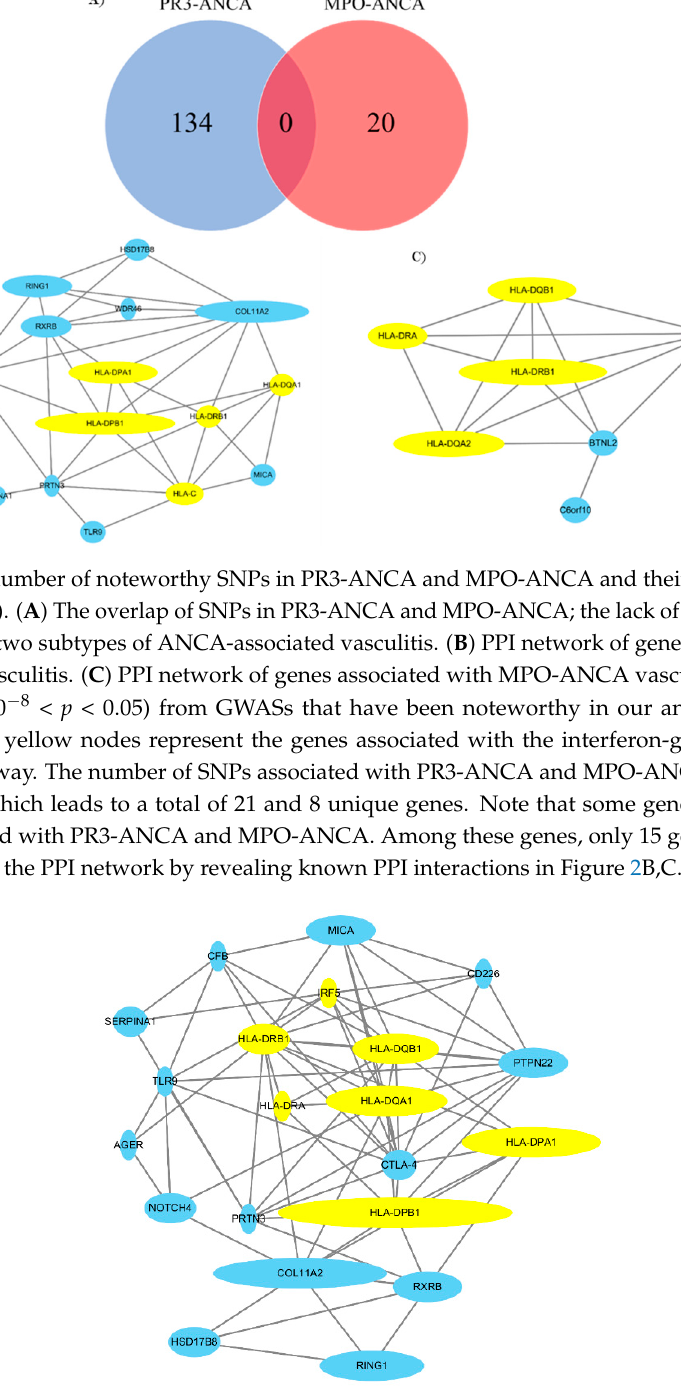
Figure 3. Protein–protein interaction network of associated genes in the etiopathogenesis of ANCA-associated vasculitis. The size of the node indicates the number of noteworthy SNPs of each gene. This network includes noteworthy SNPs and GWAS SNPs. The variants are listed in Table S7. The yellow nodes represent the genes associated with the interferon-gamma-mediated signaling pathway.